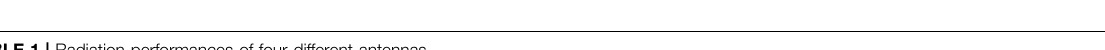
TABLE 1 | Radiation performances of four different antennas. MNM antenna with a single metallic patch as the radiation source ( Figure 3